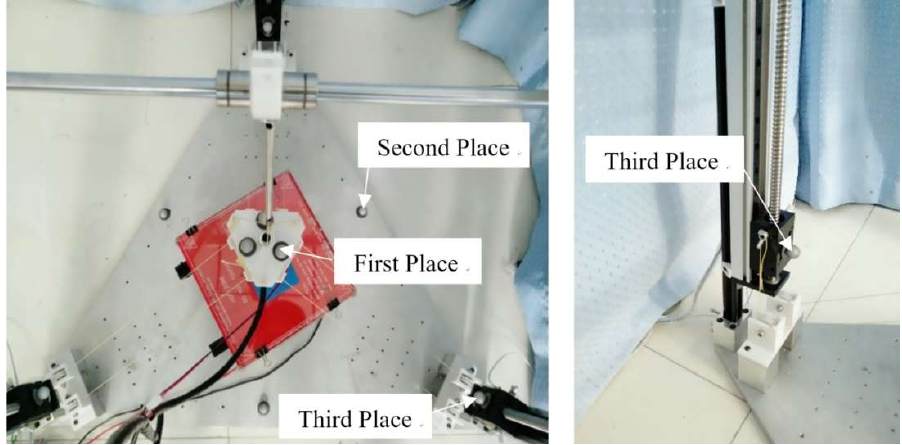
Figure 10. The layout of the markers.